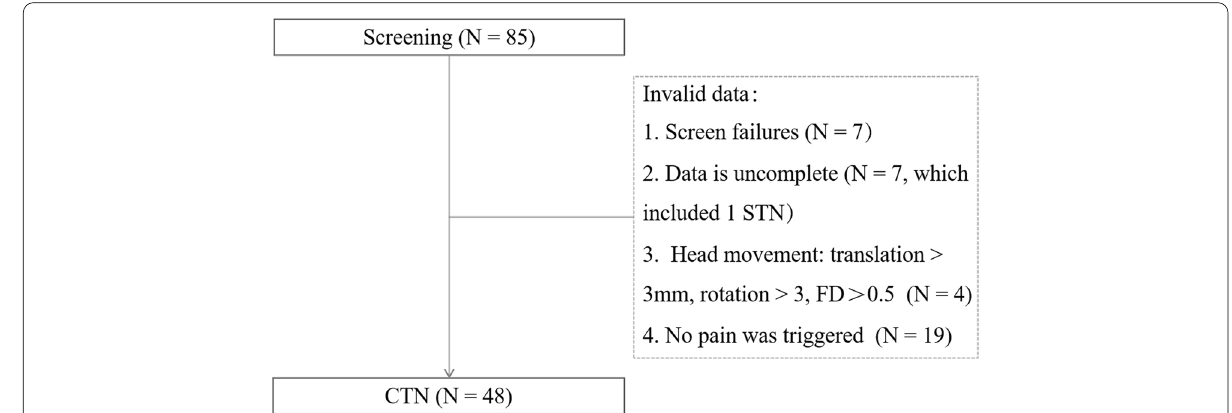
Fig. 1 Participant selection. FD, Framewise displacement